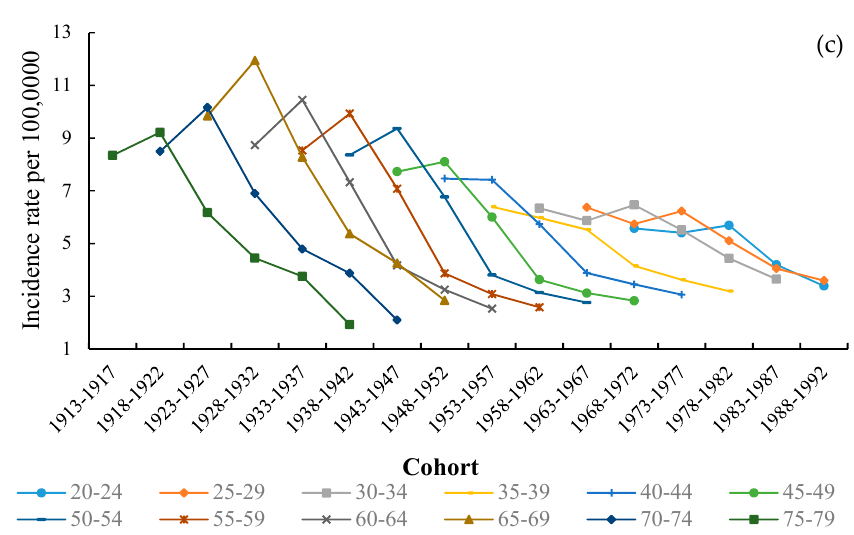
Figure 5. Cohort-based variation in age-specific TB incidence in ( a ) China, ( b ) India, ( c ) United States.